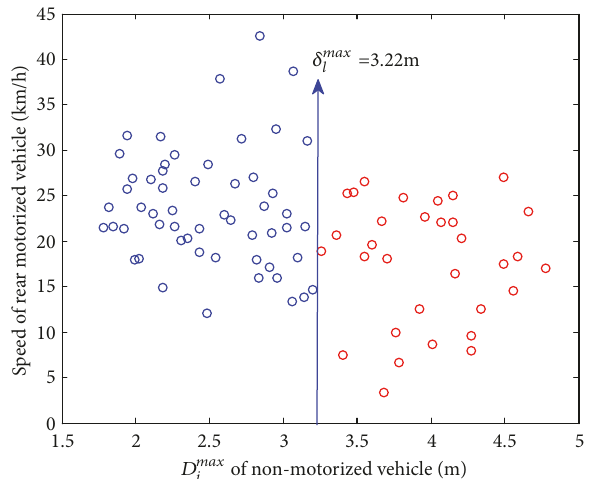
Figure 4: Relationship between 𝐷 𝑚𝑎𝑥 𝑖 and 𝑣 𝑟𝑒𝑎𝑟 𝑖 at the Changji- Moyu intersection.When 𝛿 𝑚𝑎𝑥 𝑙 = 3.22𝑚 , the difference between the average speed of rear vehicles when 𝐷 𝑚𝑎𝑥 𝑖 ≥ 3.22 𝑚 and 𝐷 𝑚𝑎𝑥 𝑖 < 3.22 𝑚 reaches the maximum.